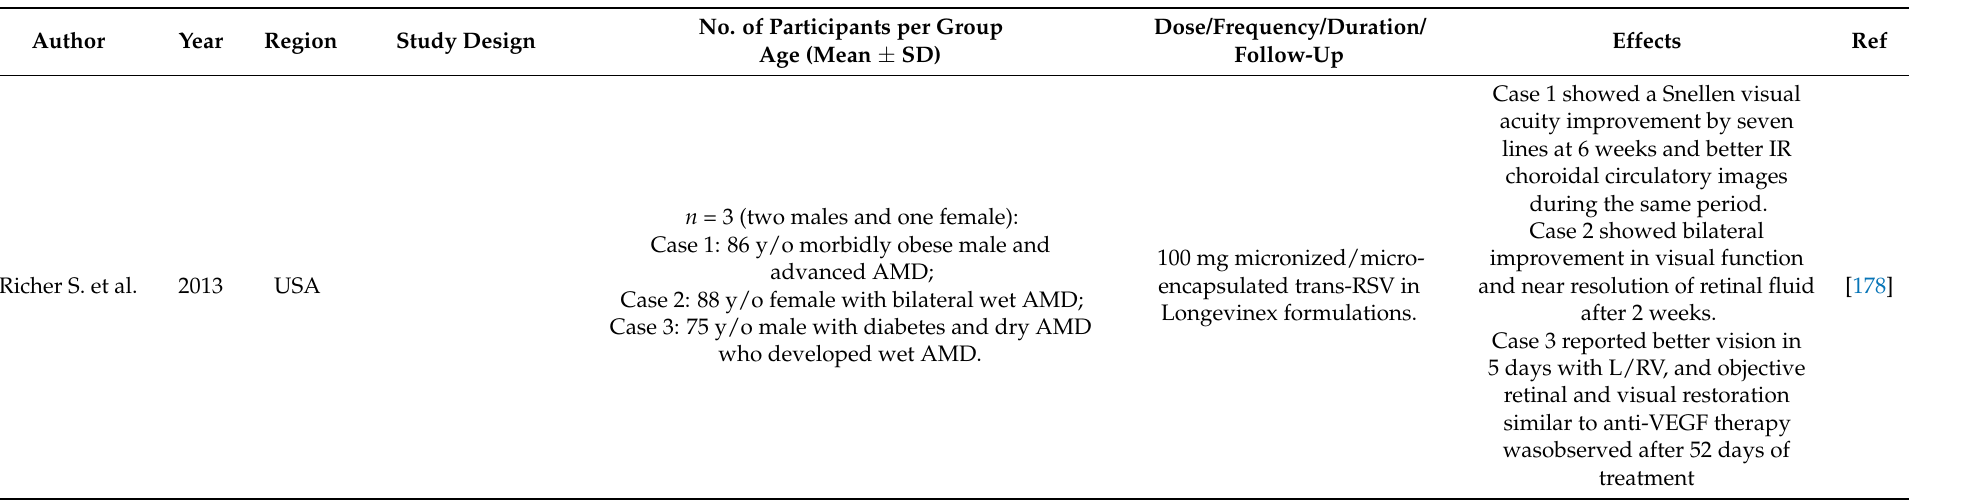
Table 2. Clinical trials with resveratrol with ocular